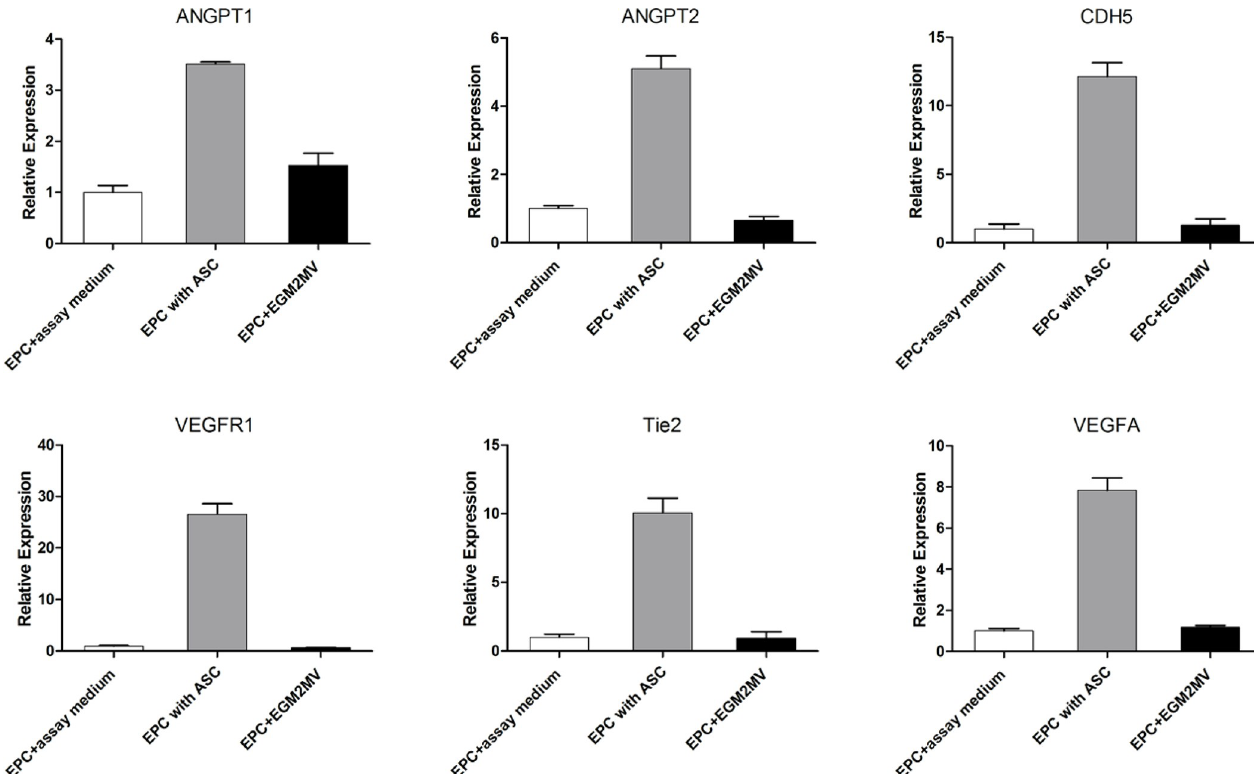
Fig 6. Coculture with ASCs promote the expression of angiogenesis markers in EPCs. EPCs were cocultured with ASCs or an equivalent volume of empty EGM2 assay medium or complete EGM2 medium as controls. After coculture for 24 hours, EPCs were harvested for qPCR detection of the expression of angiogenesis markers including VEGFA, ANGPT1, ANGPT2, CDH5, VEGFR1, and Tie2. Levels below the threshold for detection are depicted as ND. Data are expressed as mean ± SEM. � , P < 0.01.